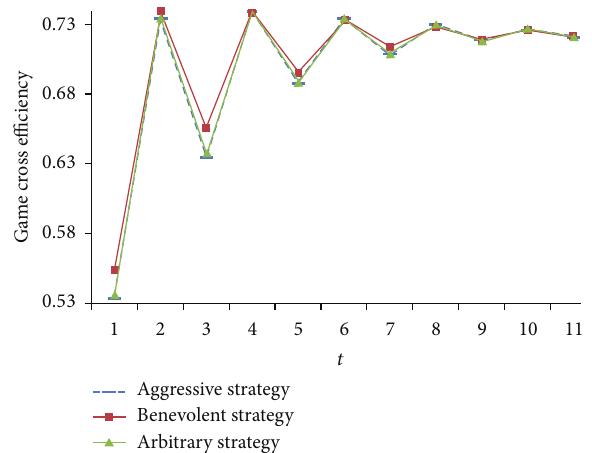
Figure 3: Iteration process for the first stage of DMU10.